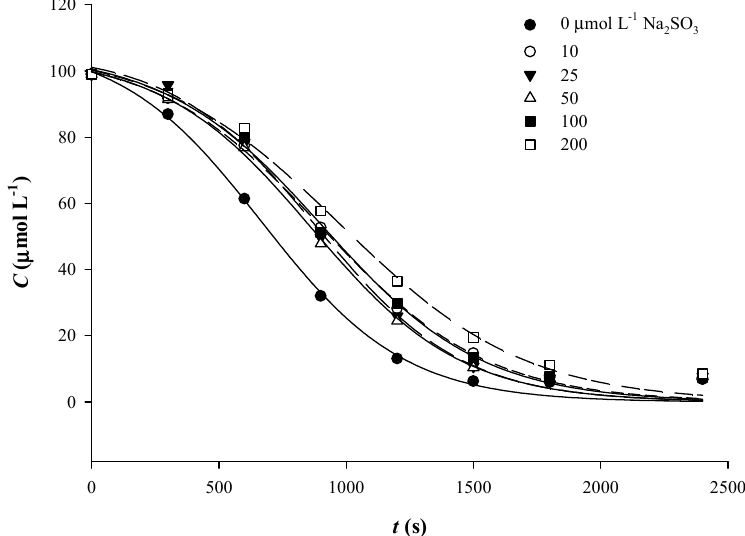
Figure 7. Implementation of the sigmoidal kinetic model to trace Qt thermal degradation in the presence of various concentrations of sulfite.